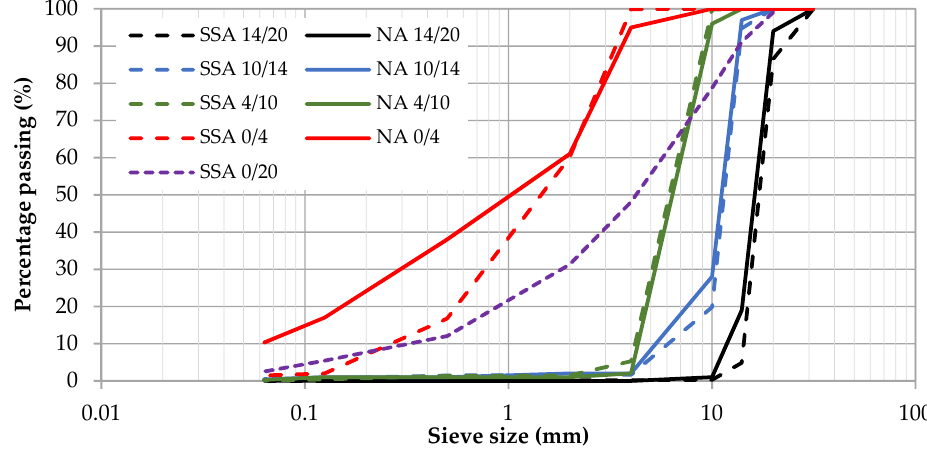
Figure 5. Particle size distribution of the different fractions of SSA and NA.